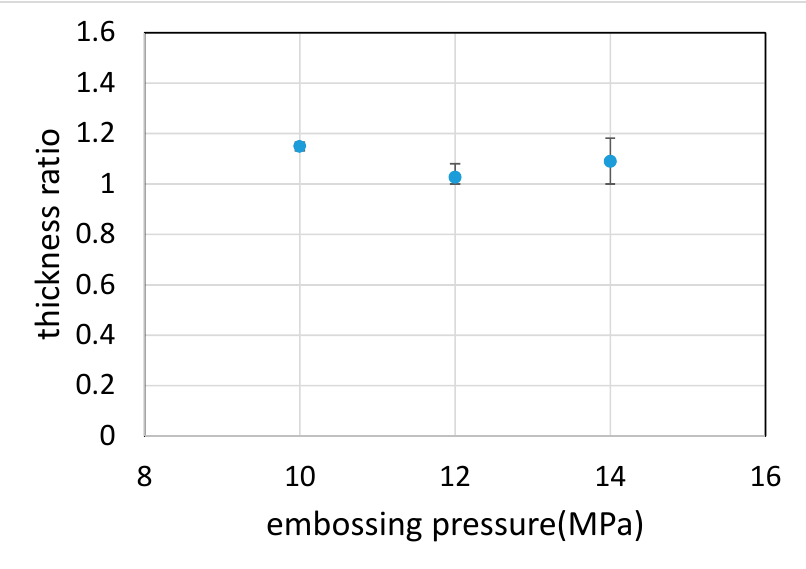
Figure 5. The thickness ratio at different embossing pressure. The thickness ratio was defined as the thickness of the filter paper in the unembossed region divided by that in the embossed region.